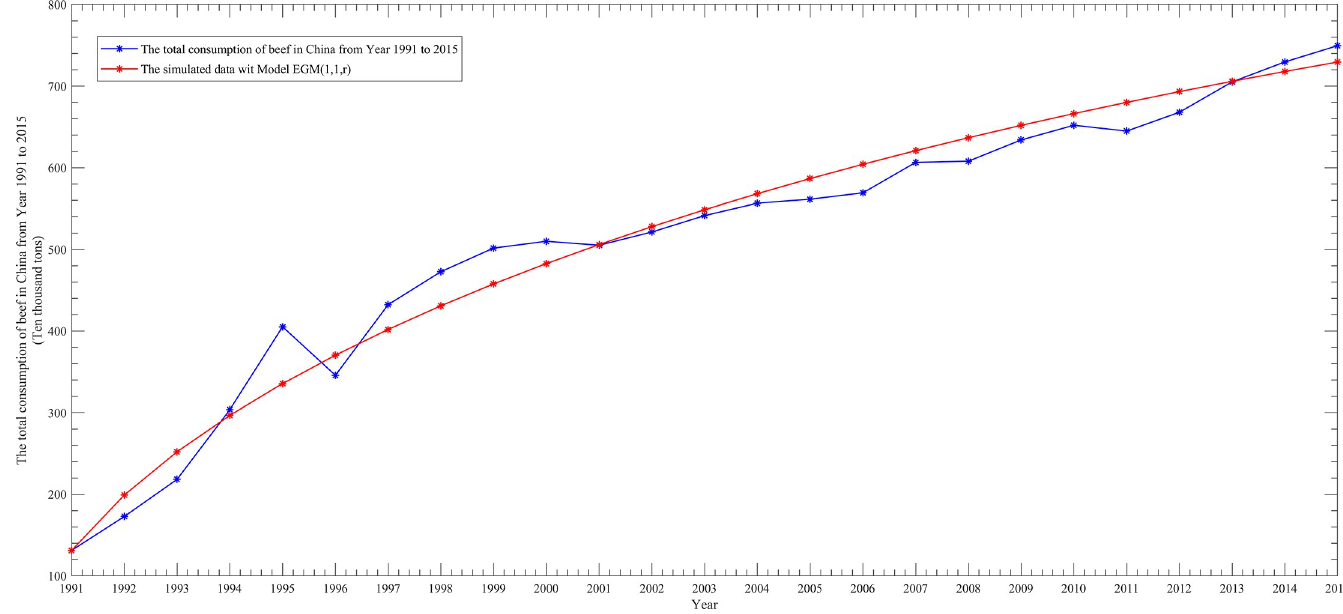
Fig 2. Curves of the actual data and simulated data of the EGM(1,1, r )model.